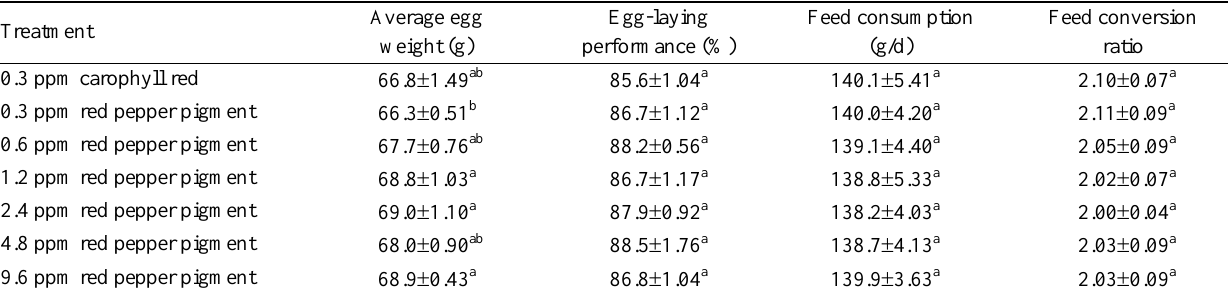
Table 2. Effect of red pepper pigments on the production performance of laying hens (Exp. 1) 1,2